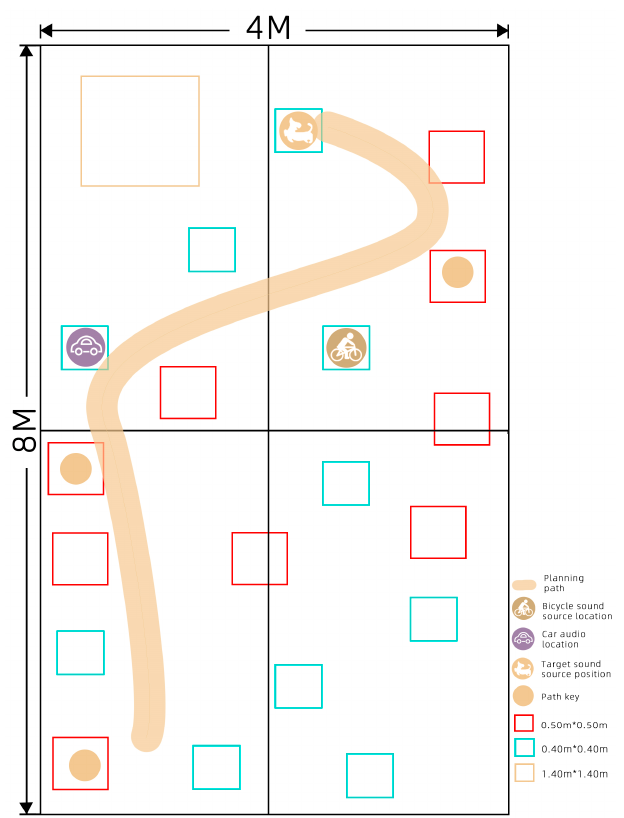
Figure 6. Schematic diagram of the experimental site.